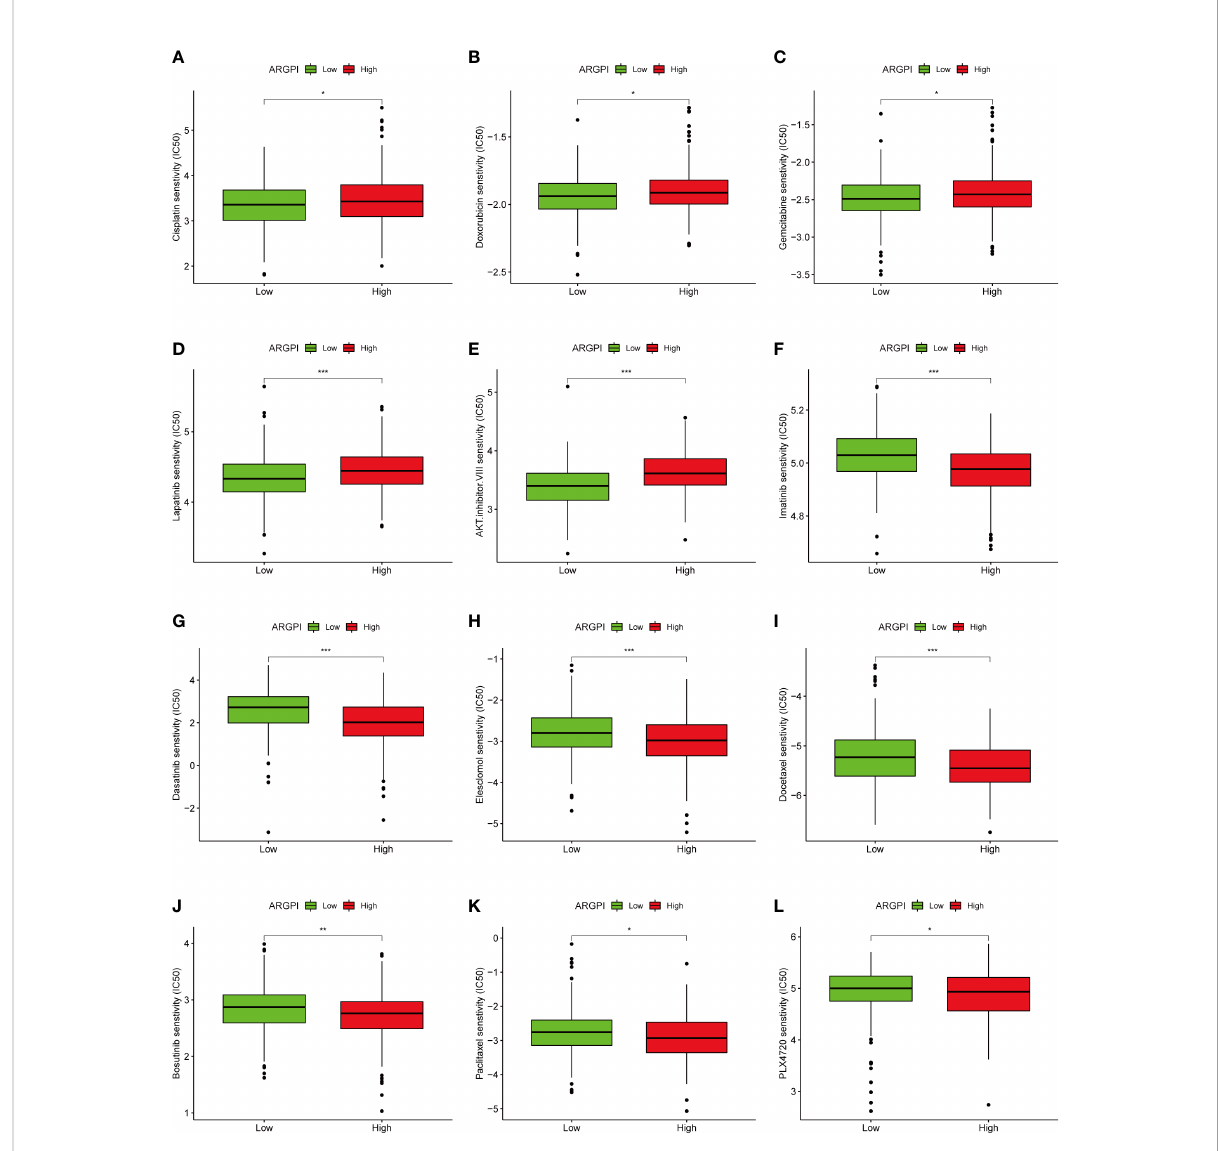
FIGURE 9 The relationship between ARGPI and treatment sensitivity. (A – L) Differences in sensitivity of 12 common drugs among different ARGPI groups. “ * ” represents p < 0.05, “ ** ” represents p < 0.01, and “ *** ” represents p <